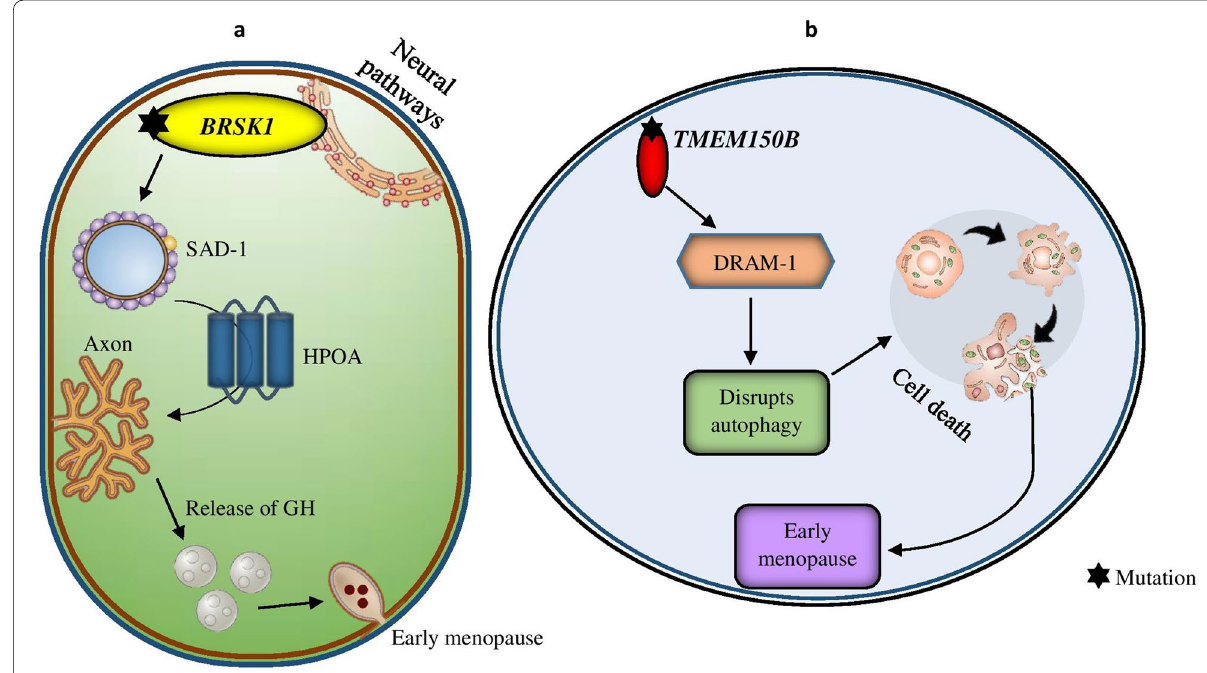
Fig. 4 Genes involved in the early menopause. a BRSK1 and b TMEM150B mutation in the development of premature ovarian failure in